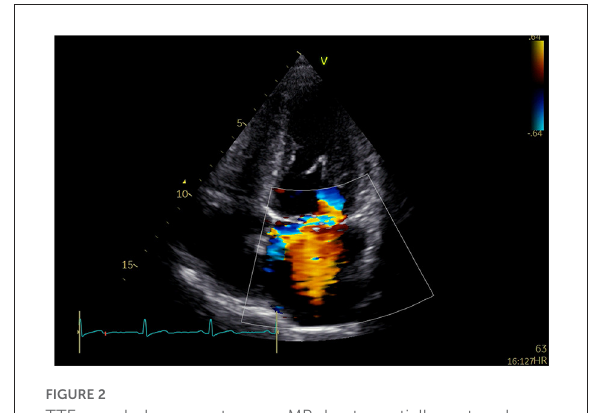
FIGURE2 TTE revealed recurrent severe MR due to partially ruptured artificial